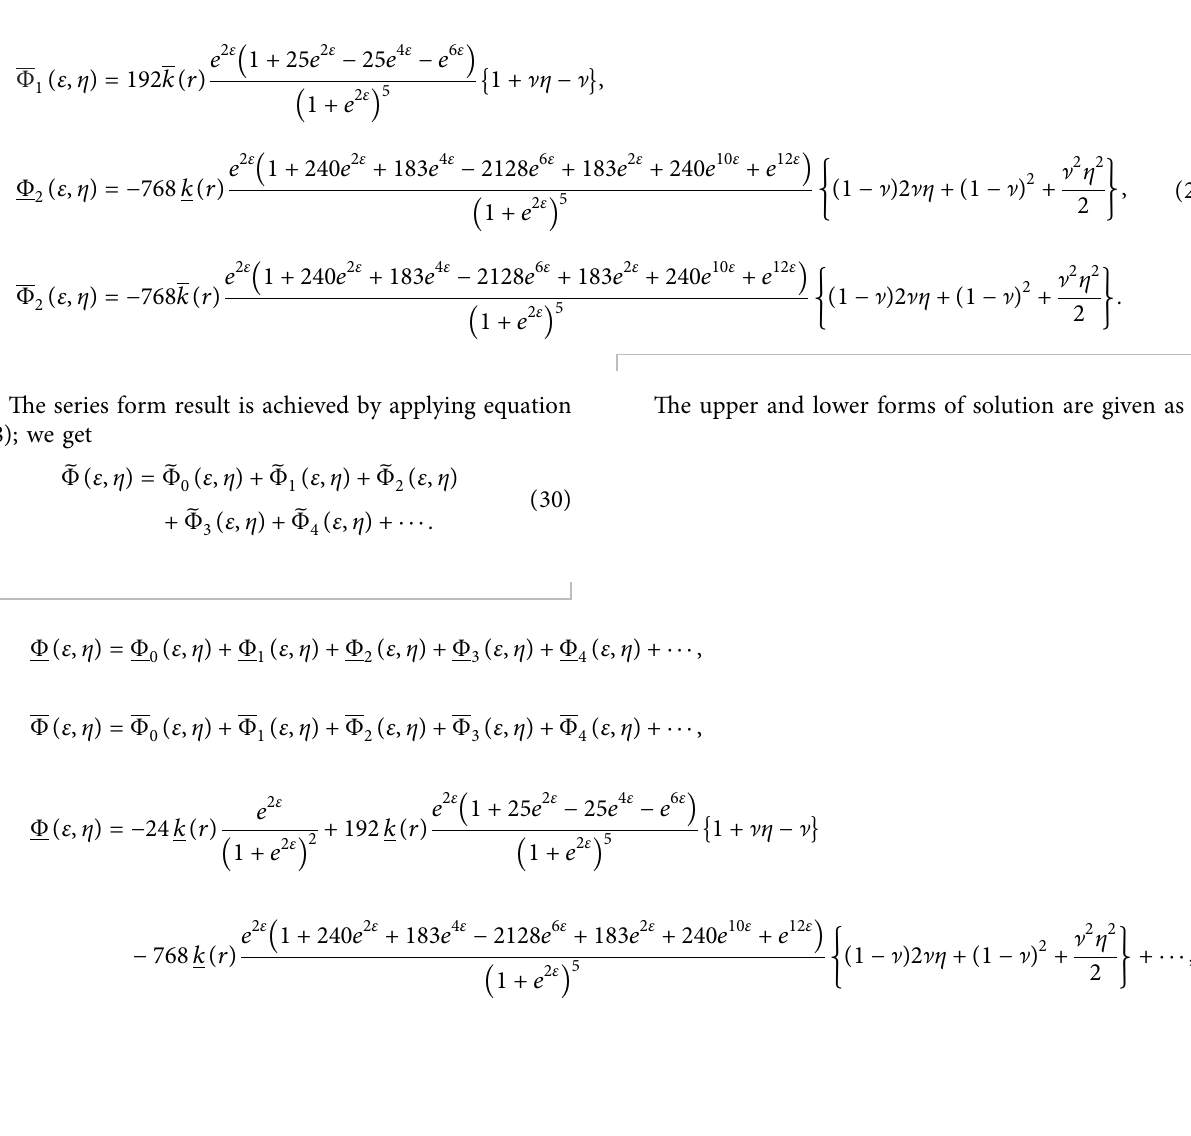
Figure 5: Upper and lower fuzzy figure of analytical solution of example